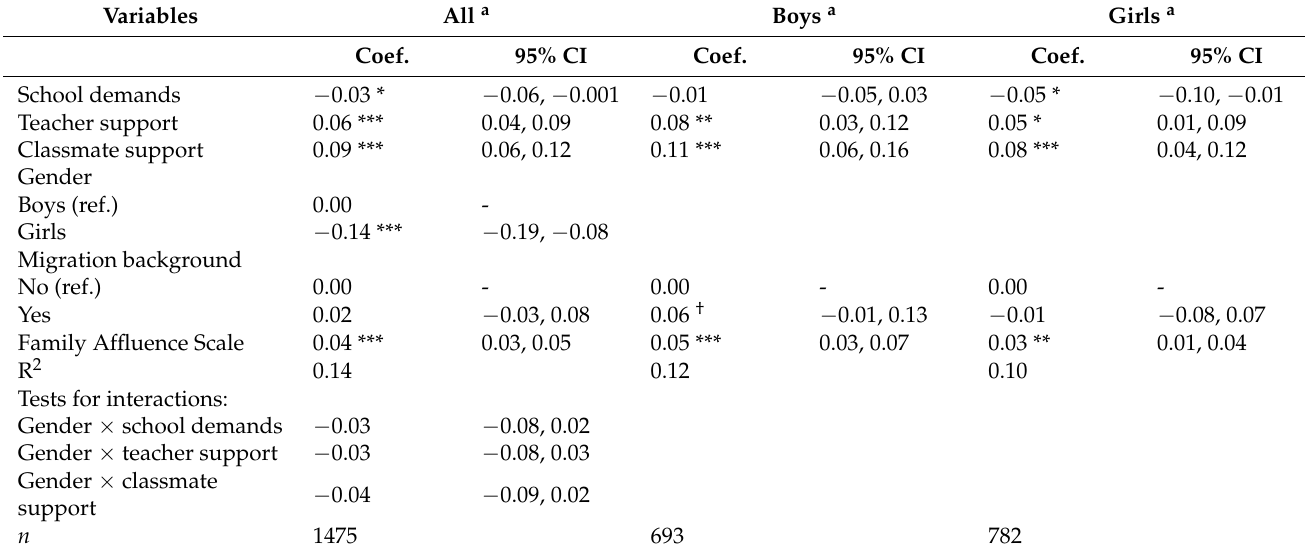
Table 3. Results from the linear probability models of excellent self-rated health among grade nine students ( n = 1475, distributed over 78